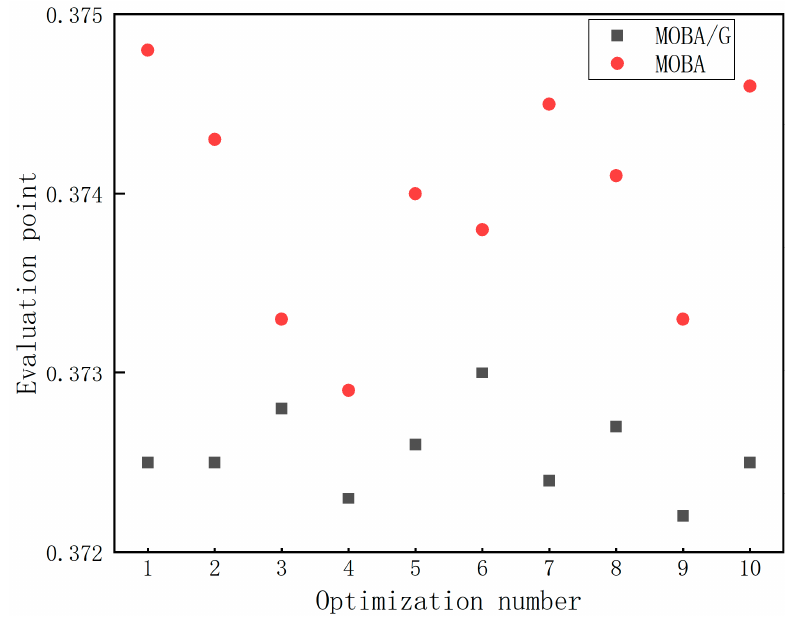
Figure 5. Ten optimization results of MOBA and MOBA/G.